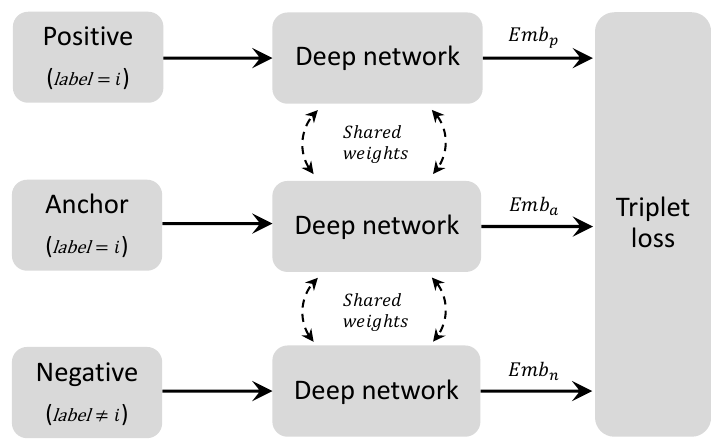
Figure 3: The structure of the triplet network. Each deep network is identical to the others. From the implementation perspective, any of these networks can be used to generate embeddings for anchor, positive, and negative